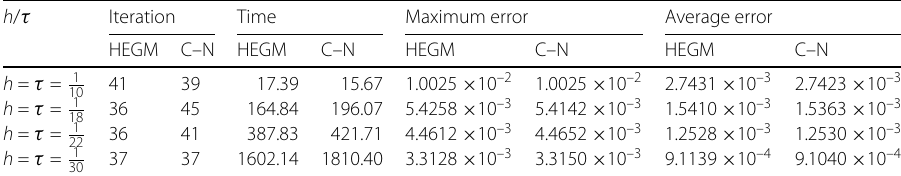
Table 4 Comparison between C–N high-order finite difference method and HEGM for Example 2 when γ = 0.75